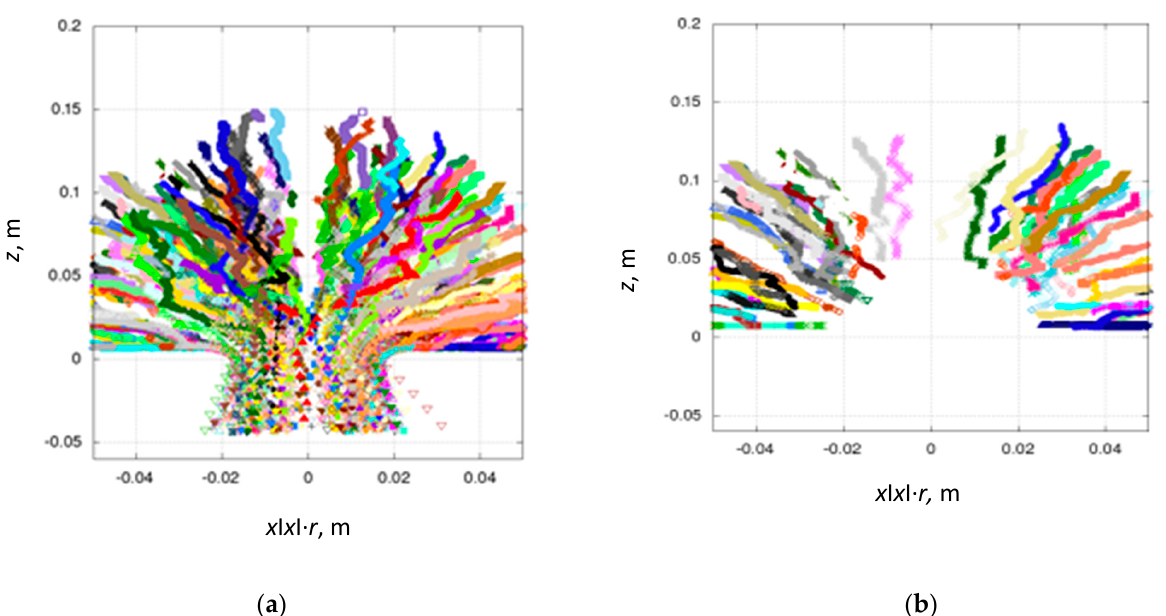
Figure 11. Typical trajectories of particles at discharge commencement: all particles ( a ) and particles that will eventually form the dome ( b ).